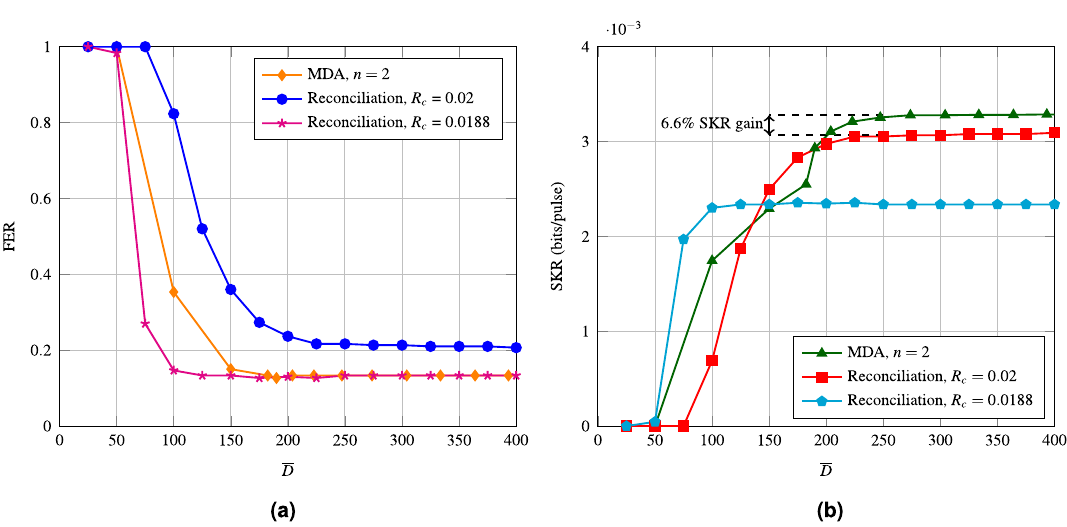
Figure 4. ( a ) FER of MDA compared to an LDPC code with R c = 0.02, and to an LDPC code with R c =